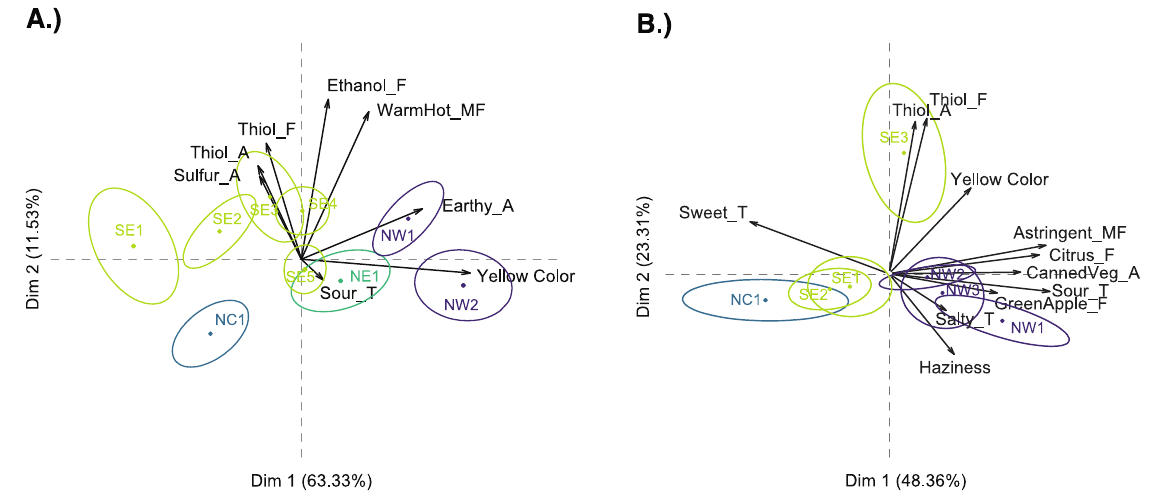
Figure 2. Principal component analysis (PCA) biplot for the significant wine sensory attributes of Year 1 (made in 2018) ( A ) and Year 2 (made in 2019) ( B ) Grüner V. wines. Wines are shown with 95% confidence ellipses and colored by region. Attributes ending in A indicate orthonasal aroma, F indicate in-mouth flavor, MF indicate mouthfeel, and T indicate taste attributes.